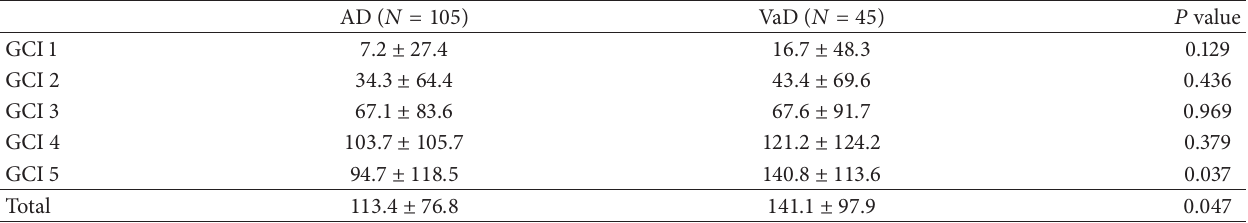
Table 3: Average payments for each GCI stage for both AD and VaD groups per month.